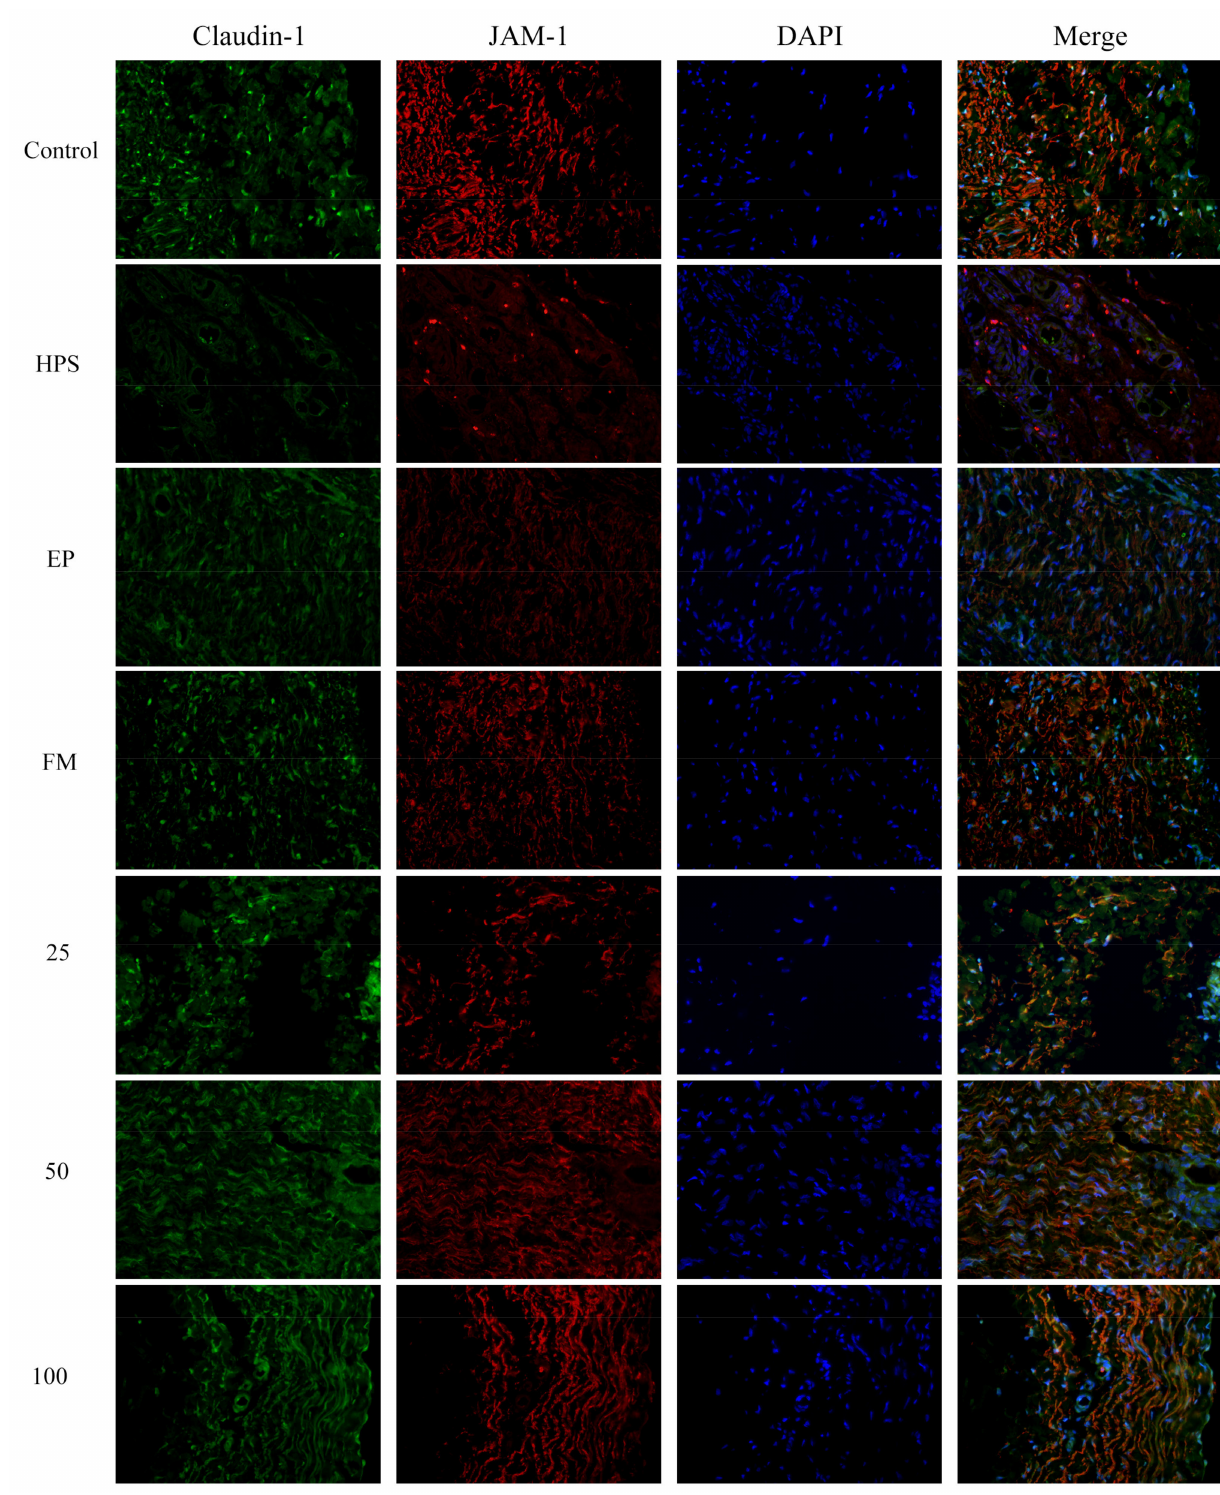
Figure 5. Effect of baicalin on the distribution patterns of claudin-1 and JAM-1 in the peritoneum of piglets challenged with G. parasuis (magnification 10 × 40). HPS: G. parasuis group, EP:EP + G. parasuis group, FM:FM + G. parasuis group, 25:25 mg/kg baicalin + G. parasuis group, 50:50 mg/kg baicalin + G. parasuis group, 100:100 mg/kg baicalin + G. parasuis